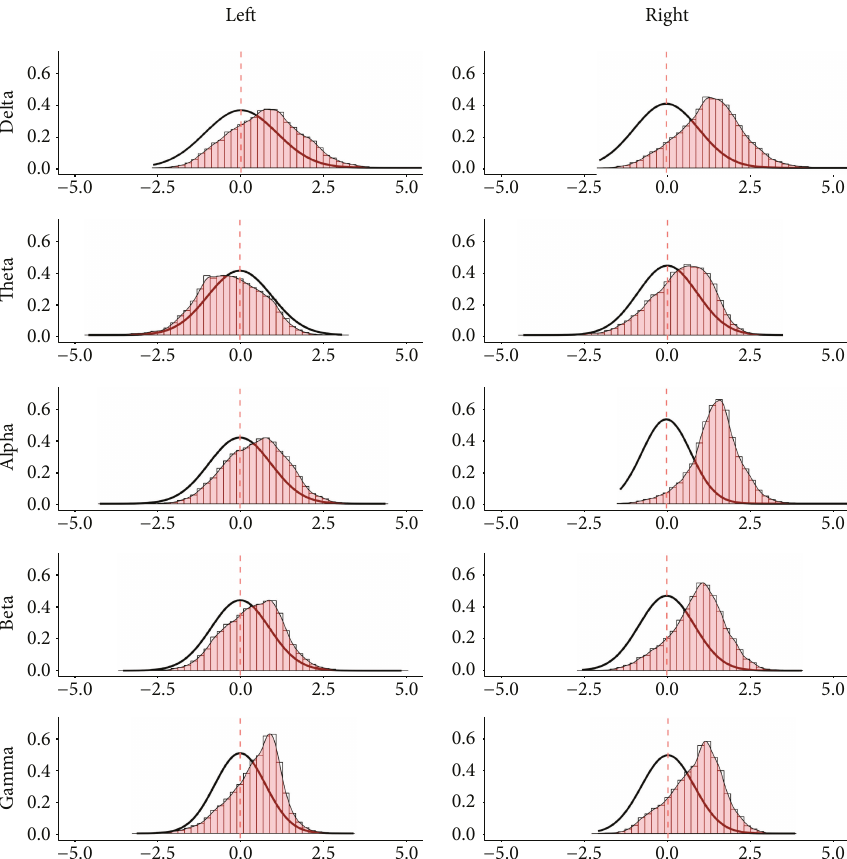
Figure 4: Resting-state connectivity (PLV) cortical t -value distribution. The fi gure shows the distribution of the t -values for the phase locking value maps calculated at the source level. The histogram with red bars and density plot with the thin line were calculated from the observed t - value distribution. The tick black line shows the theoretical null-hypothesis distribution, with zero mean and the same variability of the empirical distribution. Results are presented in an array divided in rows and columns (bands by seeds). x -axes: t -value; y -axes: frequency of cortical vertices exhibiting a speci fi c t -value expressed as proportion on the entire sample